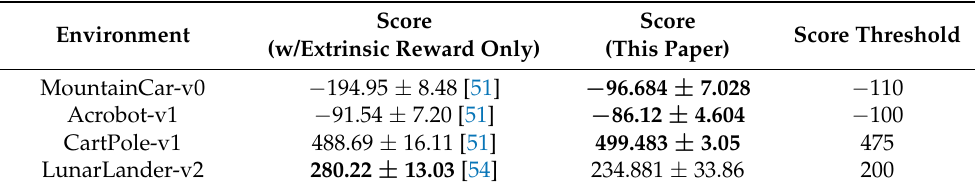
Table 3. The comparison of DQN’s performance using solely extrinsic reward and intrinsic reward. The results are evaluated based on the score, where a more positive score signifies better performance. The task’s completion requires surpassing the score threshold in the last column, and both approaches attained it for all environments. The superior outcomes are highlighted in bold.